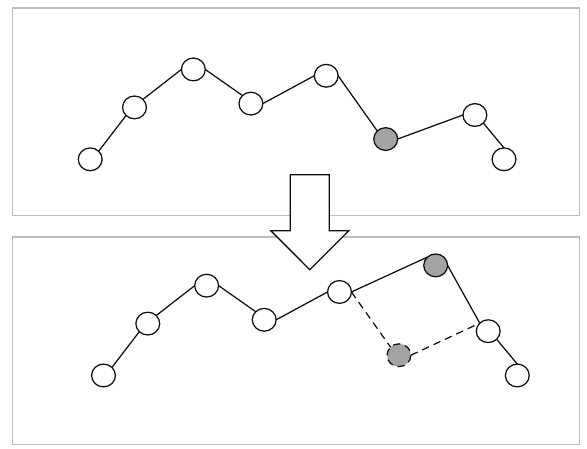
Figure 14: Apply flip mutation operator to generate offspring.